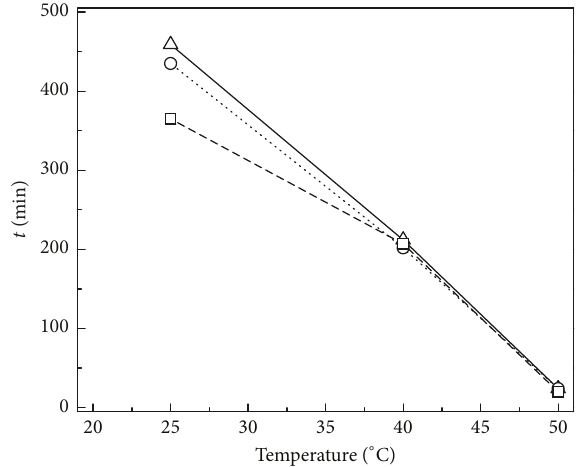
Figure 7: Experimental settling time as a function of the tempera- ture. Tank with no internals and no coalescing aid. Disperse phase (oil) holdup: 0.5 ( △ ), 0.25 ( I ), and 0.2 ( ◻